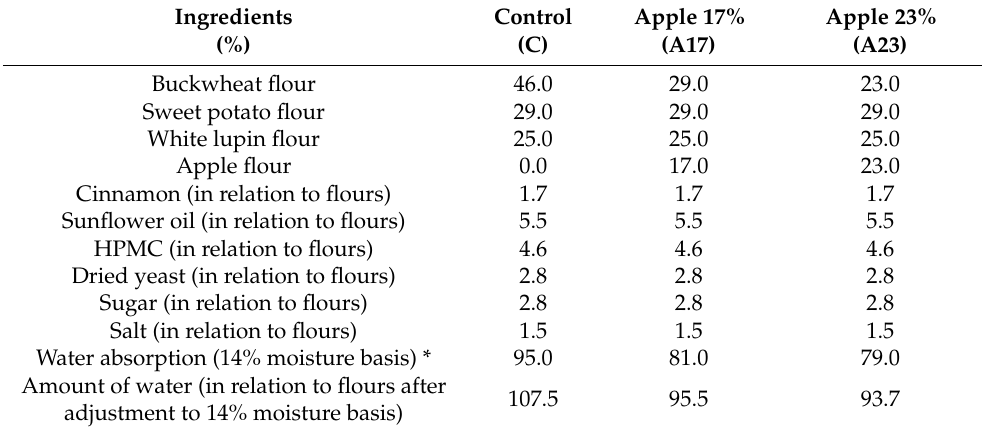
Table 1. Formulation of the gluten-free dough (GFD) samples and respective